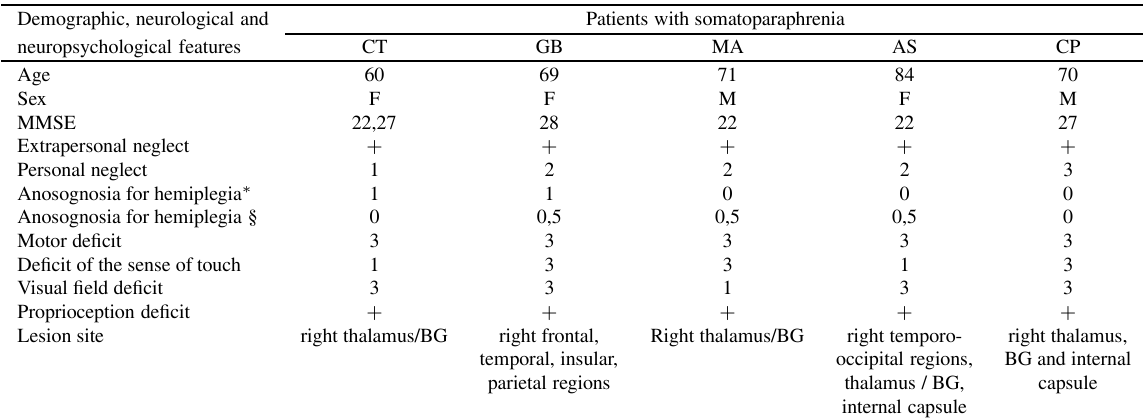
Table 2 Features of the patients. Neurological, neuropsychological and anatomical characteristics of CT, GB, MA, AS and CP Demographic, neurological and Patients with